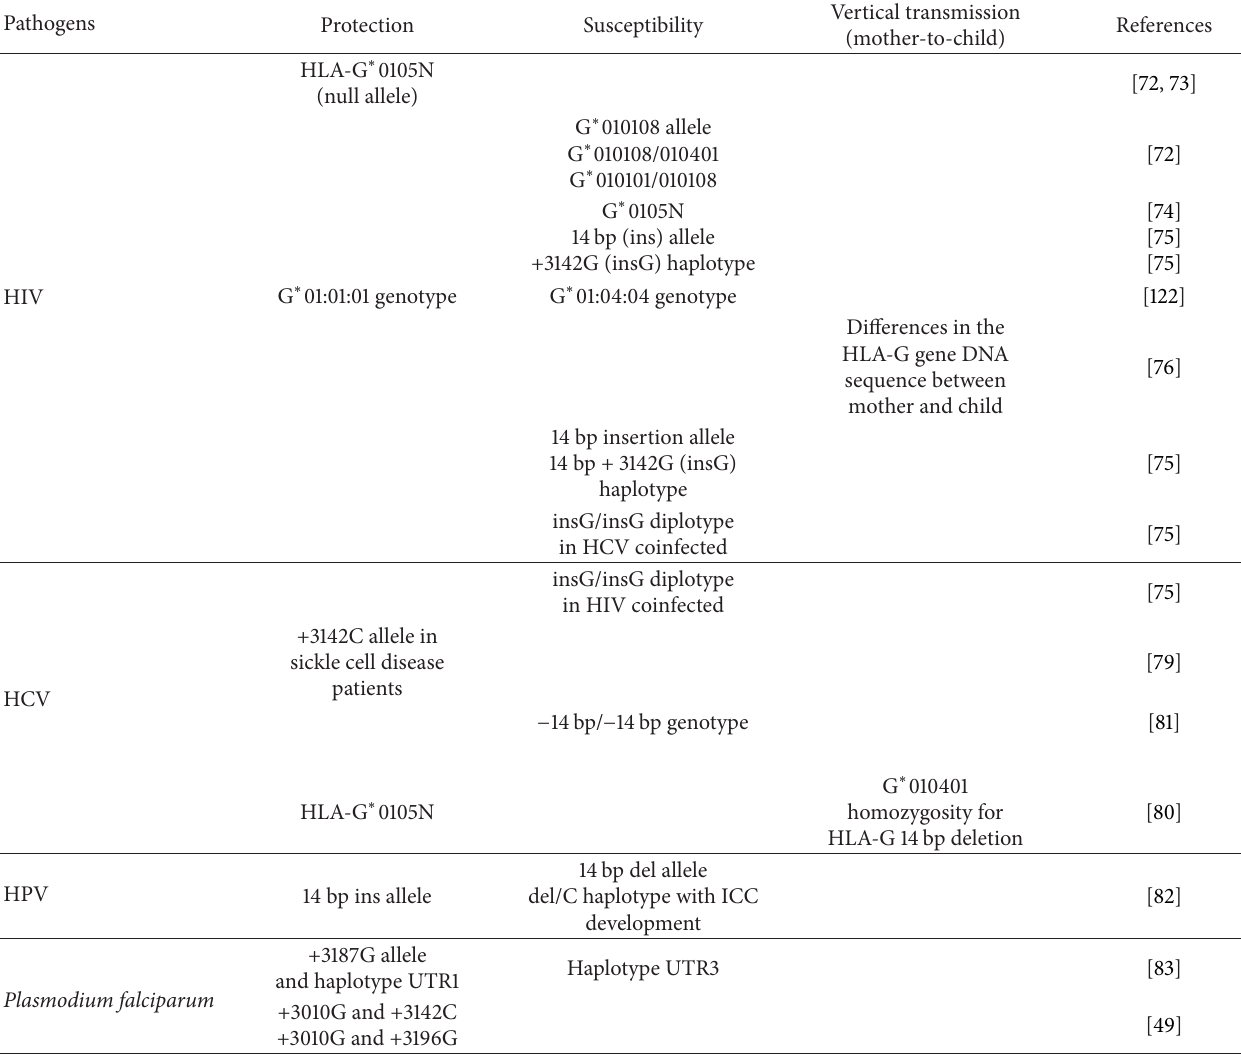
Table 2: Influence of HLA-G polymorphism on susceptibility to infectious